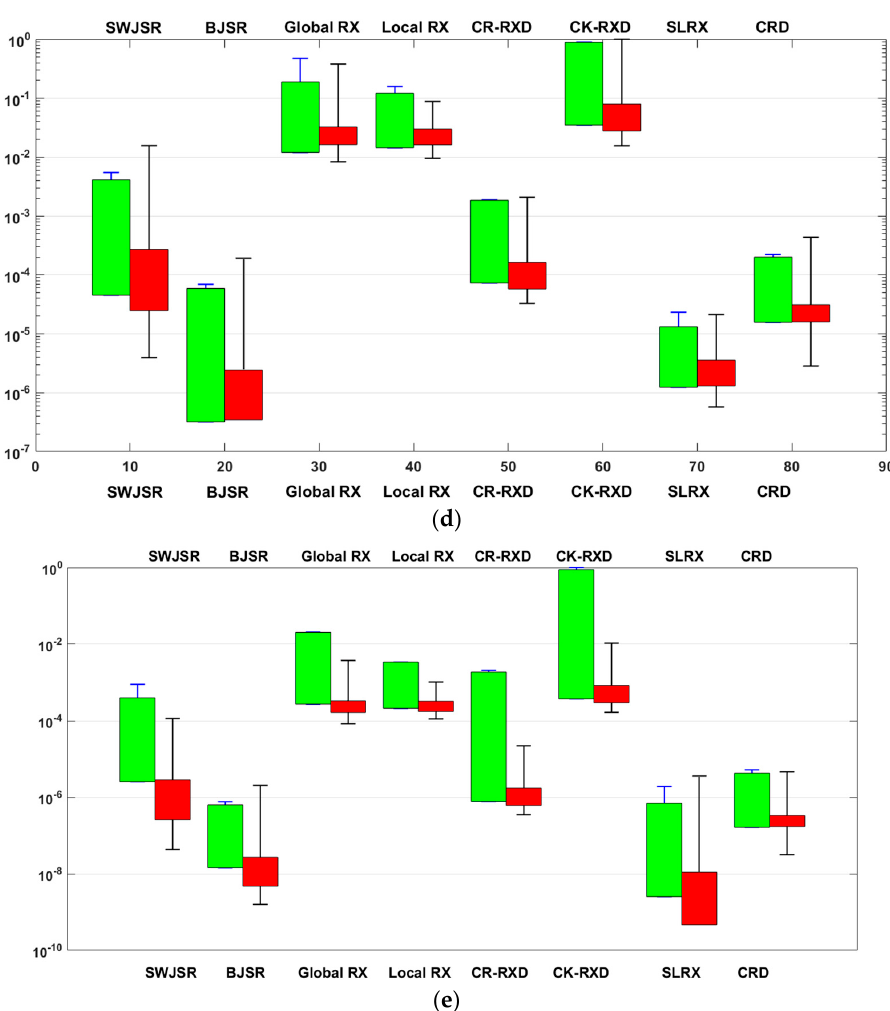
Figure 11. Target-background separation diagram of the anomaly detection algorithms (the green box shows the target and the red box shows background statistics): ( a ) real RIT dataset; ( b ) real San Diego dataset; ( c ) real Viareggio dataset; ( d ) implanted RIT dataset; and, ( e ) destructed RIT dataset.